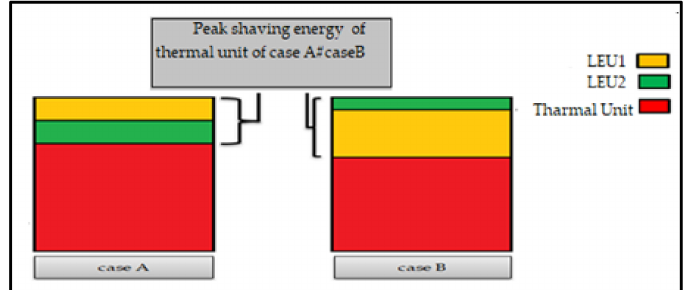
Figure 1. Selected thermal unit that peak shaved its energy from several optimized limited energy units (LEUs) having di ff erent a ff ected